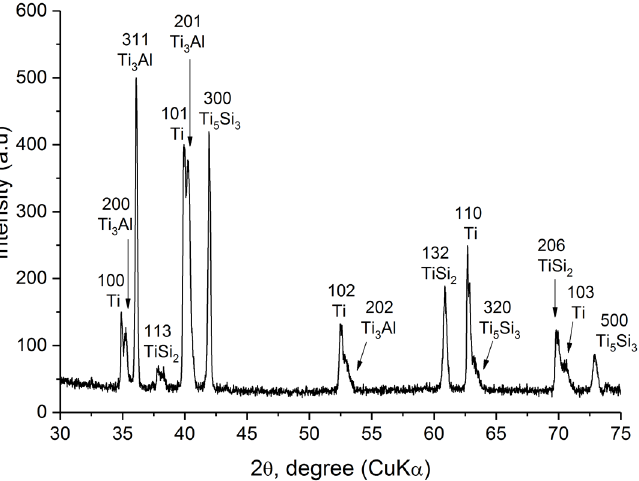
Figure 3. XRD patterns of Ti–Al samples after Si + implantation after annealing at 1000 ° С .